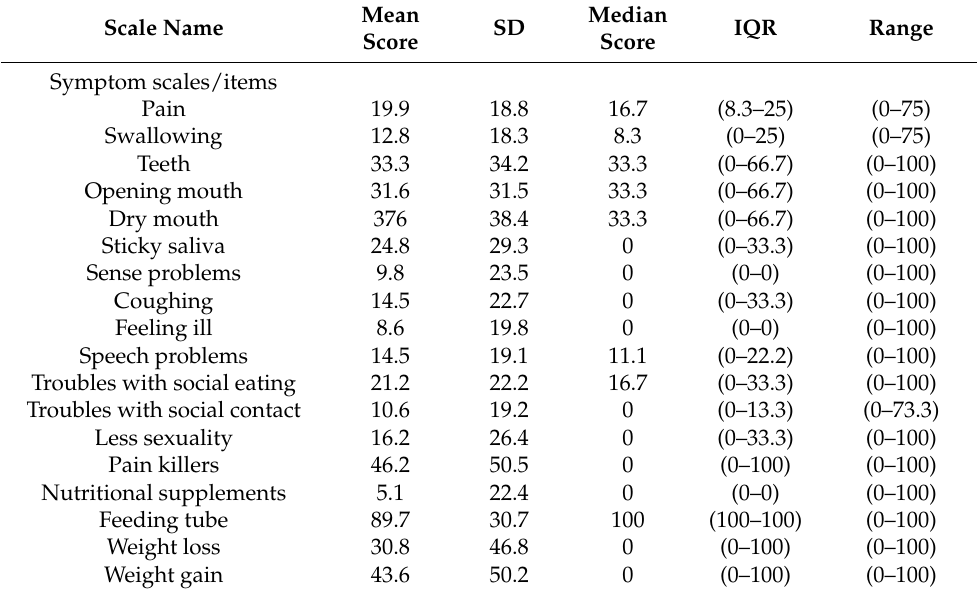
Table 3. Total scores for QLQ-H&N35 questionnaire.